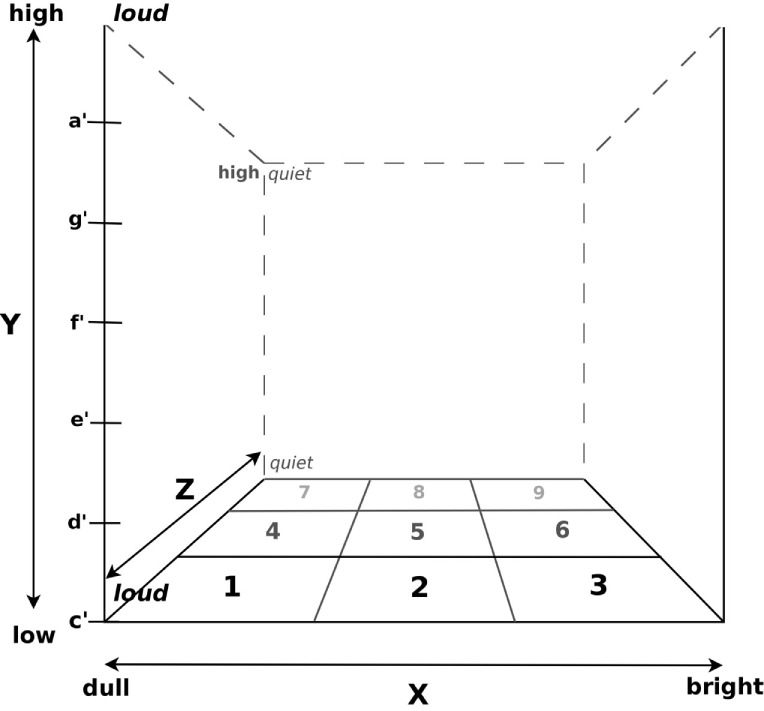
The 3D space defined by a wooden frame. Pitch was mapped onto the y-axis ranging from c′ at the bottom to a′ at the top. Brightness was mapped onto the x-axis from the left (dull) to the right (bright) and volume onto the z-axis with loudness increasing with increasing proximity. Positions in the x–z plane were labeled for ease of instruction.